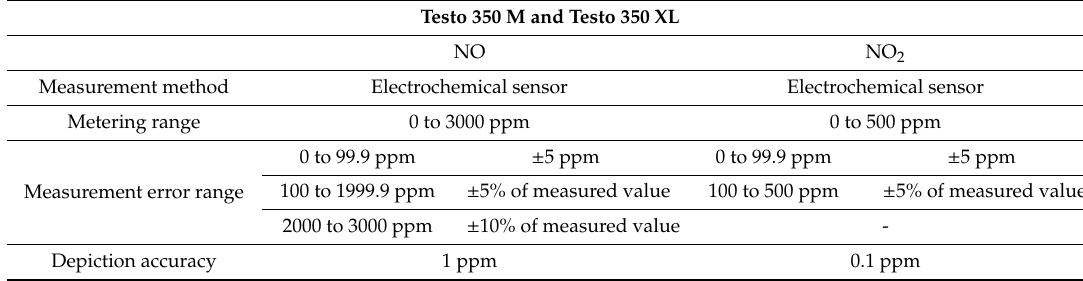
Table A1. Nitrogen oxide measurement method and measurement error range stated by Testo 350 analyzer series manufacturer [47].